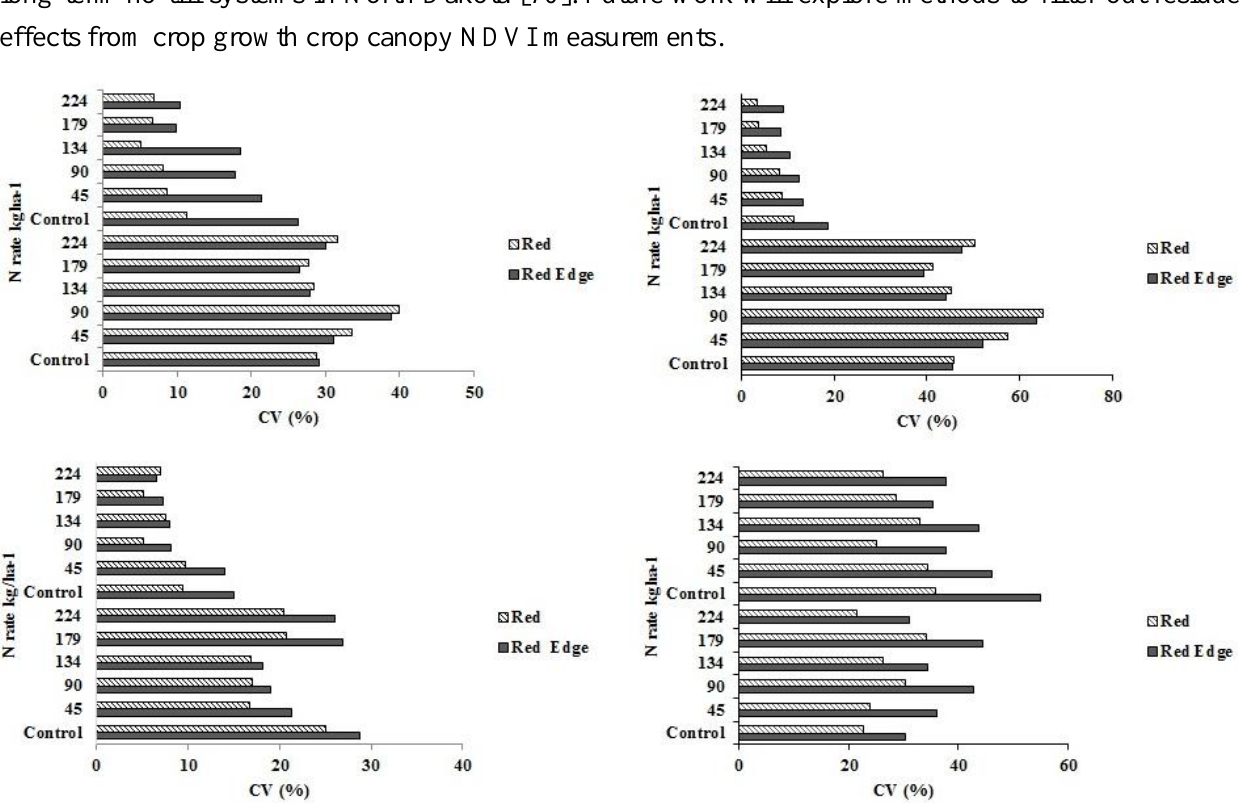
Figure 6. Percent CV (coefficient of variation) calculated from INSEY derived from sensor red or red edge NDVI in response to N rate under high clay conventional-till ( upper left ); medium textured conventional-till ( upper right ); eastern ND no-till ( lower left ); and western ND no-till ( lower right ) sites at V6 and V12 corn growth